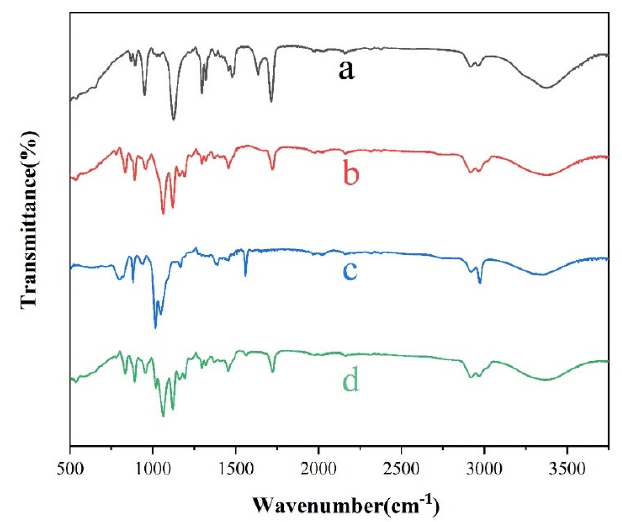
Figure 3. Fourier infrared spectrum of (a) METAC; (b) Ion-responsive polymer PTSPM-PMETAC; (c) Amino modified SiO 2 ; (d) Ion-responsive superhydrophobic coating PTSPM-PMETAC/SiO 2 -NH 2 .